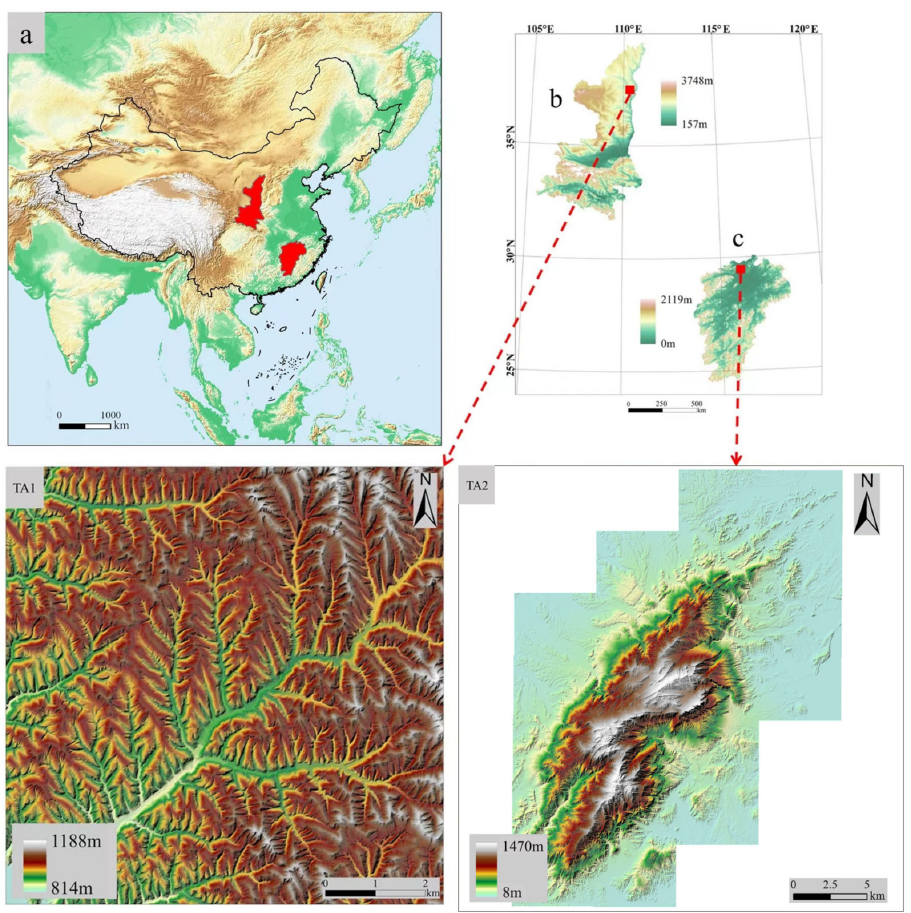
Figure 1. Field study areas: ( a ) the location of study areas (red areas); ( b ) Jiuyuangou area (TA1) in Shanxi Province; ( c ) Lushan area (TA2) in Jiangxi